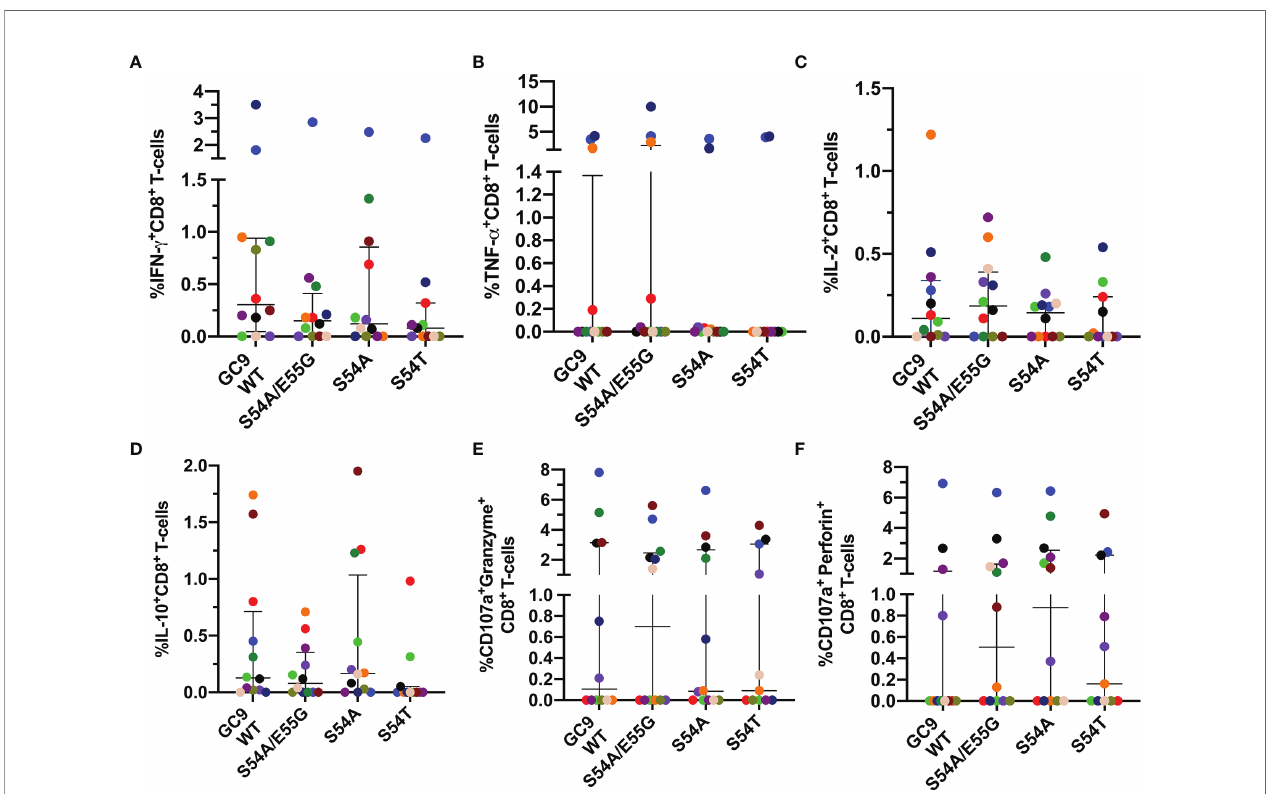
FIGURE 3 | Cytokine mediated and cytotoxic CD8 + T-cell response to GC9 WT, S54A/E55G, S54A and S54T. Frequency of CD8 + T-cells positive for IFN- g (A) , TNF- a (B) , IL-2 (C) , and IL-10 (D) , CD107a co-expressed granzyme B (E) or CD107a co-expressed perforin (F) . Each point represents the CD8 + T-cell response in an individual to each peptide (10 µg/mL) after subtraction of the negative control. Wilcoxon test was used for matched-paired samples and comparisons were made between each mutated peptide with the wild type version (GC9 WT). Plots depict the median and IQR, n =